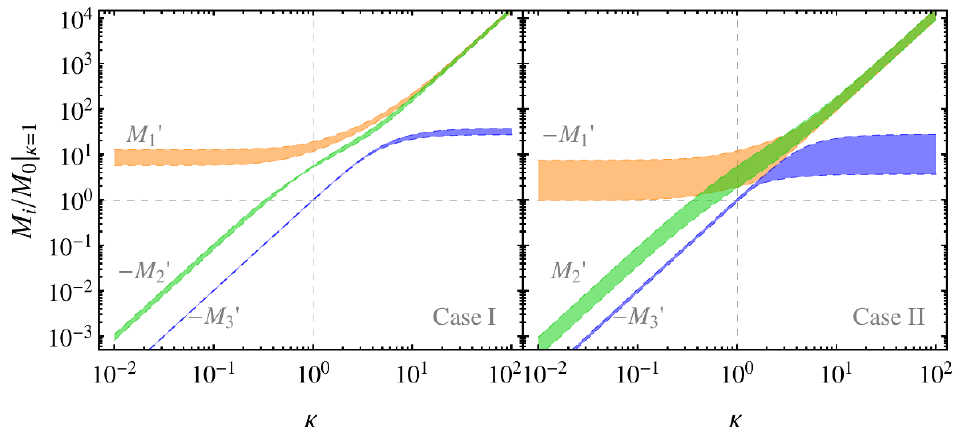
Figure 4 . Mass spectrum for NO solutions (cases I and II) relative to the lightest mass M 0 for (cid:20) = 1, for N 1 (orange), N 2 (green) and N 3 (blue), as a function of (cid:20) . We use the 3- (cid:27) ranges in ref. [56] for the observables not (cid:12)xed by symmetry. M 0 their CP parity.